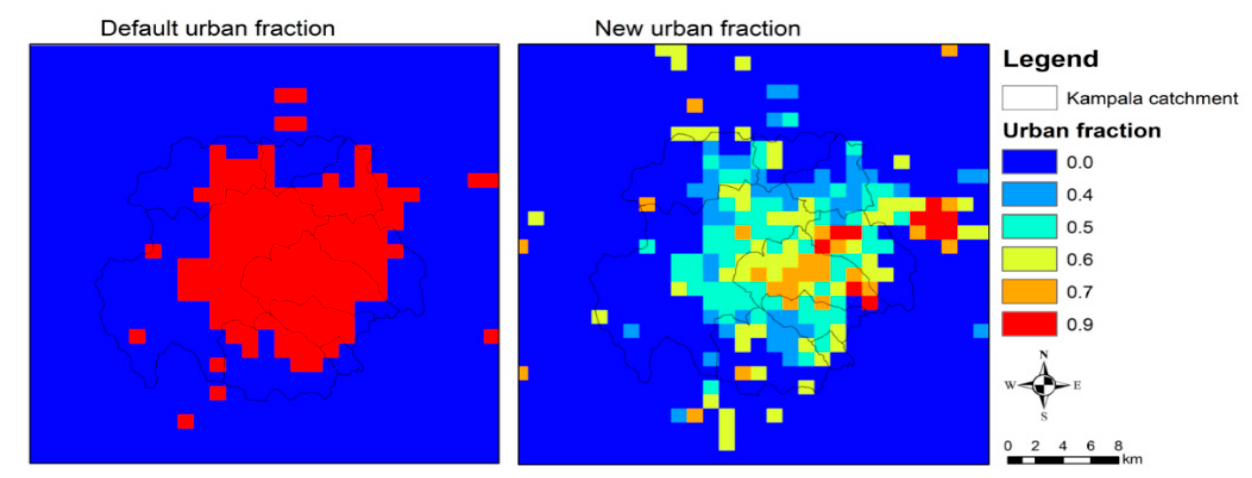
Figure 3. The default and updated urban fraction representation used in the model simulations. All pixels in the inner domain of WRF represent 1 km. The default urban fraction ( left ) is from Noah LSM based on MODIS observation [35], whereas the updated urban fraction is derived from a Landsat image developed using the cellular automata model